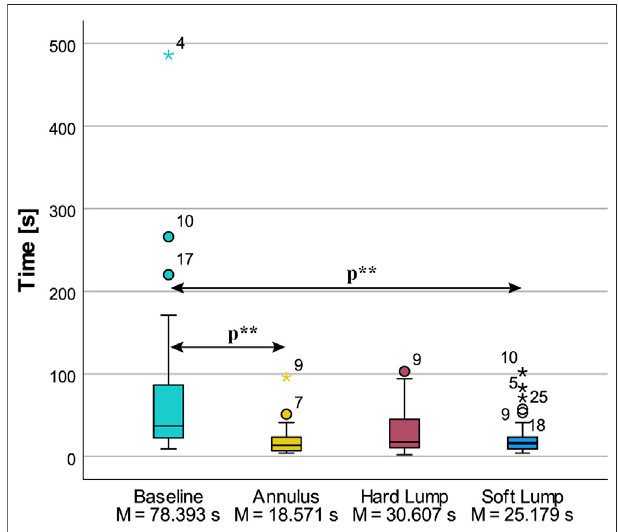
FIGURE 10 | Descriptive statistics of procedure time to fi nd the position and form of the irregularities. Statistically signi fi cant differences at p < 0.05 are indicated by p